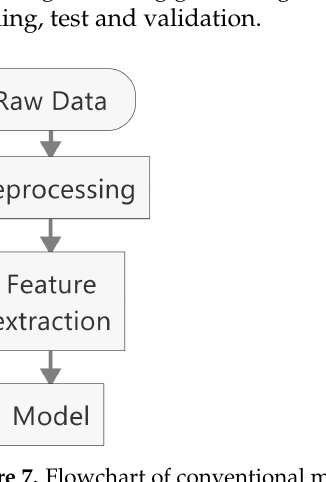
Figure 7. Flowchart of conventional machine learning.